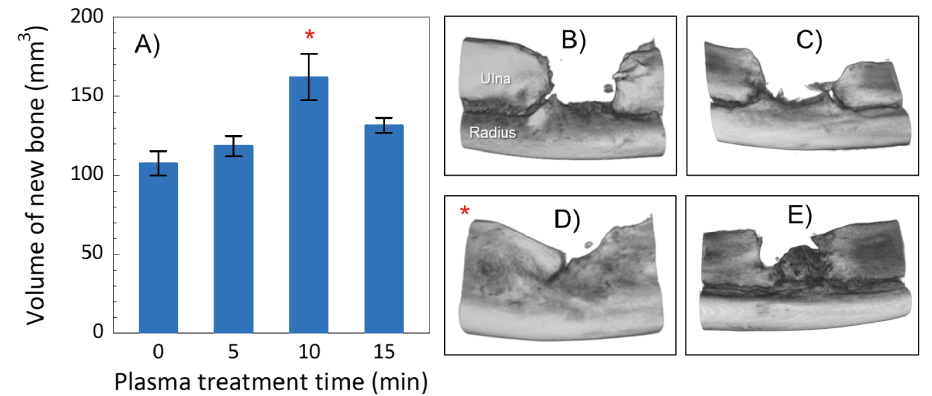
Fig 3. Micro-computed tomography ( μ -CT) analysis and pathology results. 3A evaluated the volume of new bone as plasma treatment time and 3B-3E show μ -CT images of control (0 min) and plasma treatments: C for 5 min, D for 10 min, and E for 15 min,